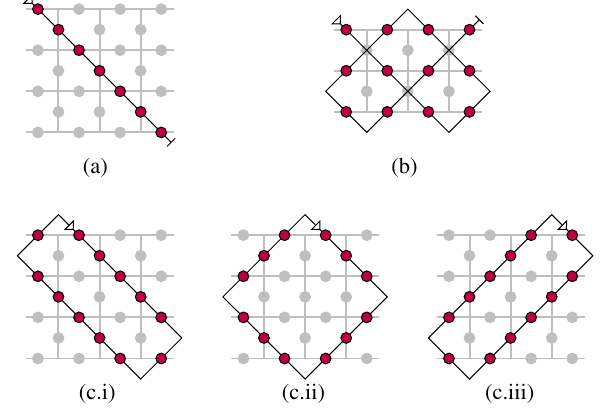
FIG. 22. Examples of Y -type stabilizer and logical operator construction by applying Y operators along the indicated path until a corner is encountered or the path cycles. Minimum-weight Y -type logical operators (a) and (b) for square 4 × 4 and coprime 3 × 4 codes, respectively, are constructed by starting at the top- left qubit. Generators of the group of Y -type stabilizers (c) for the square 4 × 4 code are constructed by starting at each of the next gcd ð j; k Þ − 1 ¼ 3 qubits of the top row. (For coprime codes, there are no Y -type stabilizers other than the